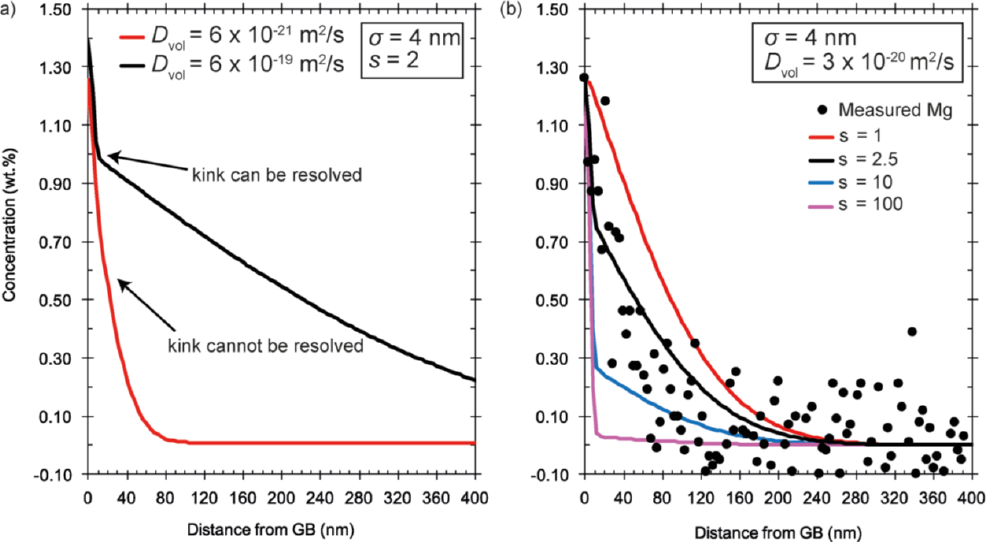
Figure 13. Convoluted profiles and the effect of the profile shape on the estimation of s . (a) Small s (such as 2) can be only detected when the profile is sufficiently long. (b) The experimental Mg data (black dots) can be fitted only if s is between